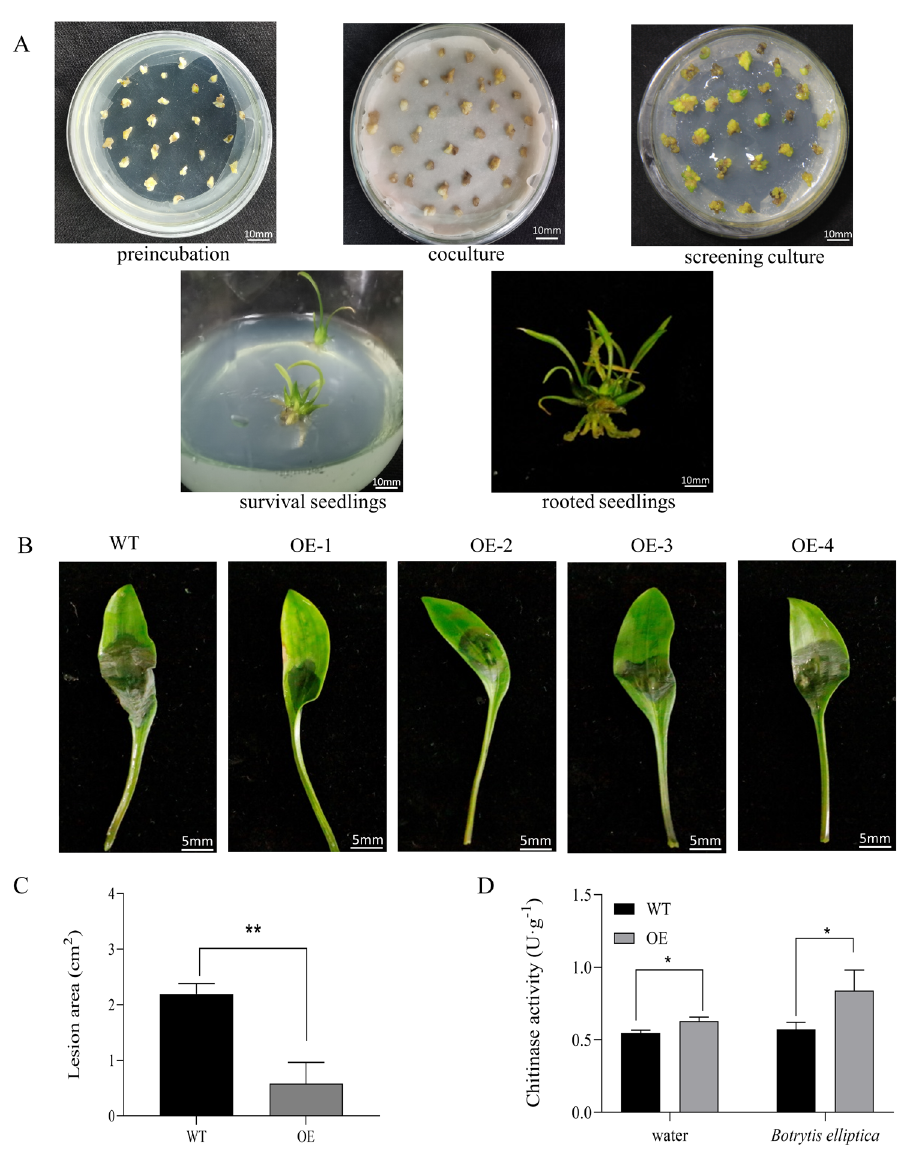
Figure 7. Effect of the overexpression of LhSorbPR4-2 on the resistance of lily leaves to Botrytis elliptica infection. ( A ) The genetic transformation process of lily ‘Sorbonne’ embryogenic callus. ( B ) Images of the leaves from transgenic and wild type (WT) plants infected with B. elliptica . OE1, OE2, OE3, and OE4 represent four LhSorPR4-2 transgenic lines. The leaves were photographed at 72 h after inoculation. ( C ) The average diameters of lesions of infected leaves at 72 h. ( D ) Chitinase activities in lily plants inoculated with B. elliptica . Error bars represent the standard errors of three biological replicates. Asterisks indicate statistically significant differences between the transgenic lines and the WT plants (* 0.01 < p < 0.05, ** p <0.01, Student’s t